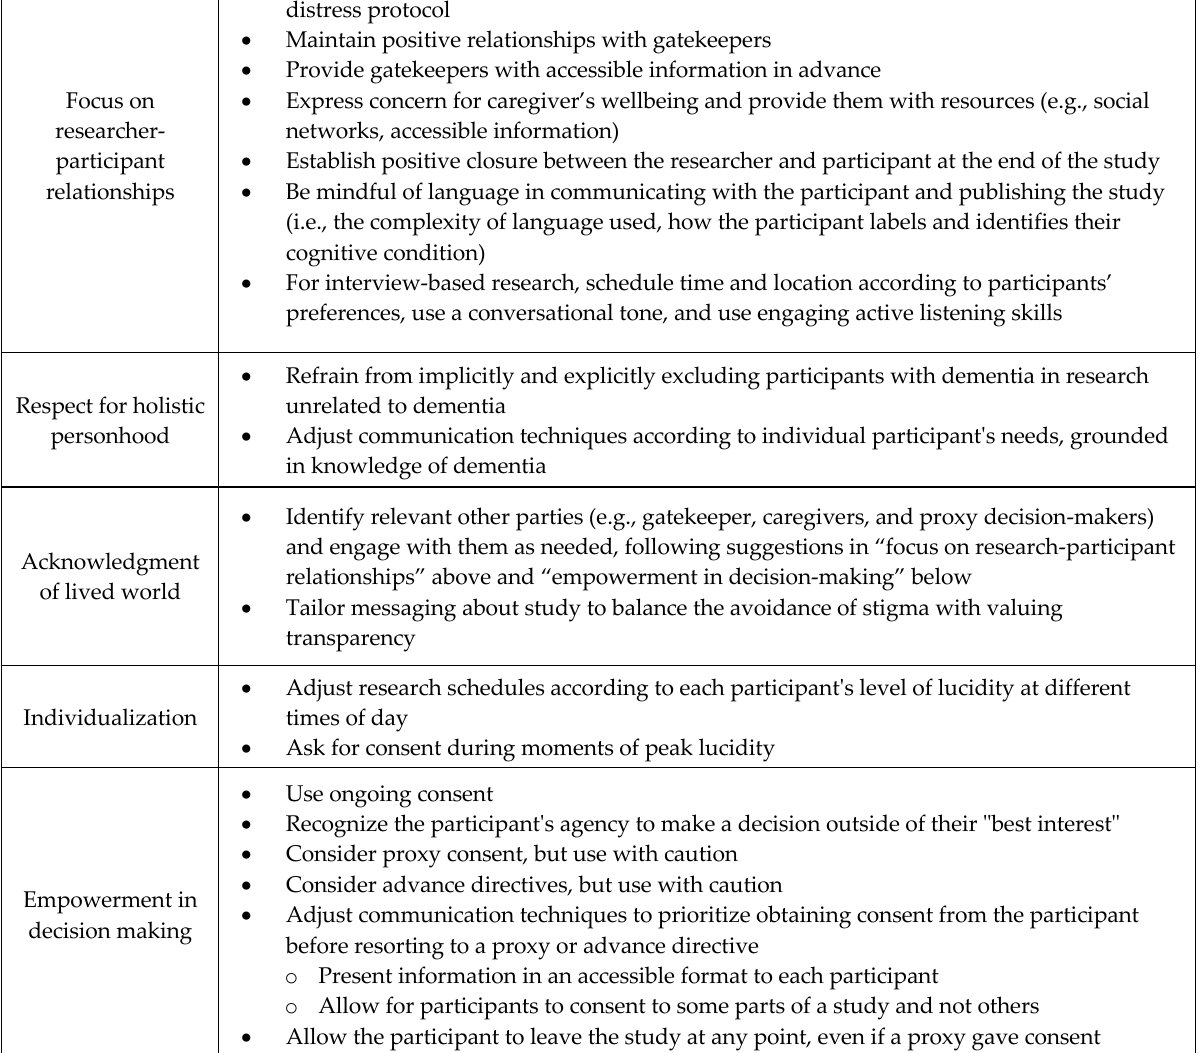
Table 2: Practical Suggestions Extracted from